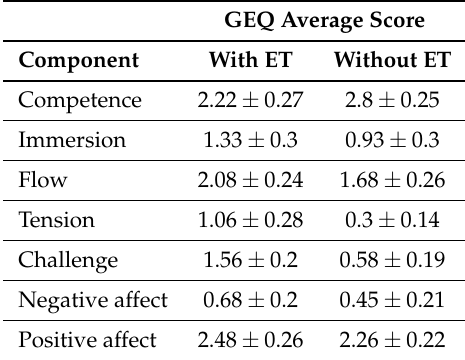
Table 2. Average values for the different components on the GEQ core module for the play sessions with and without Eye Tracking (ET). Results provided as STD ± STE, where STD stands for standard deviation and STE for standard error of the mean.